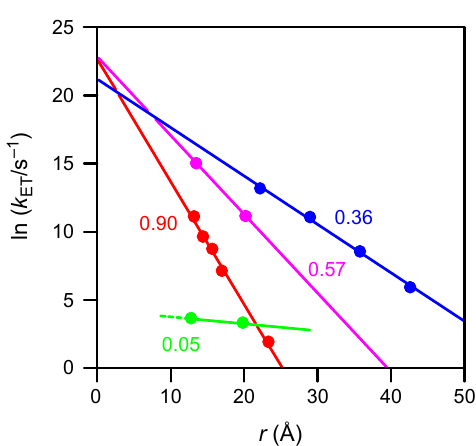
Figure 7. Plots of ln k ET versus distance for SAMs of molecular wires bridging ferrocene and gold via S–Au bonding. Green (this work), blue [34], and purple [35]: oligo( p -phenyleneethynylene) wire. Red [36]: linear alkylamide wire. Values of β are indicated.